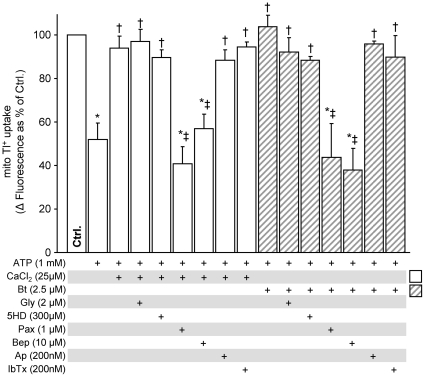
Pharmacologic characteristics of C. elegans mBK channel activity in the wildtype N2-Bristol strain.Characterization of mBK activity in isolated WT (N2-Bristol) worm mitochondria was measured using the Tl+-flux assay as in Figure 1. Mitochondrial Tl+ uptake, a surrogate for K+ flux, was measured using a mitochondrial matrix loaded Tl+-sensitive fluorophore, as detailed in the methods section of Supporting Information S1. ATP was added to block the normally open C. elegans mitochondrial mKATP channel [16]. Graph shows Δ fluorescence upon Tl+ addition to media. Channel activators and inhibitors were added as defined in Figure 1, and listed below the x-axis. Data are means ± SEM, N>4 (N = independent mitochondria preparations). *p<0.05 vs. ctrl, †p<0.05 vs. ATP, ‡p<0.05 vs. ATP+Bt.